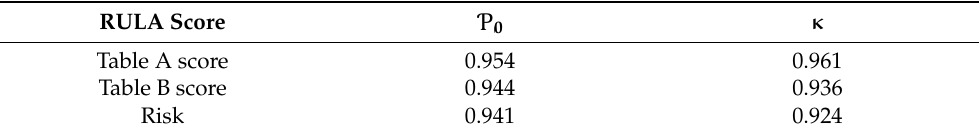
Table 11. REBA score performance with experts’ data.